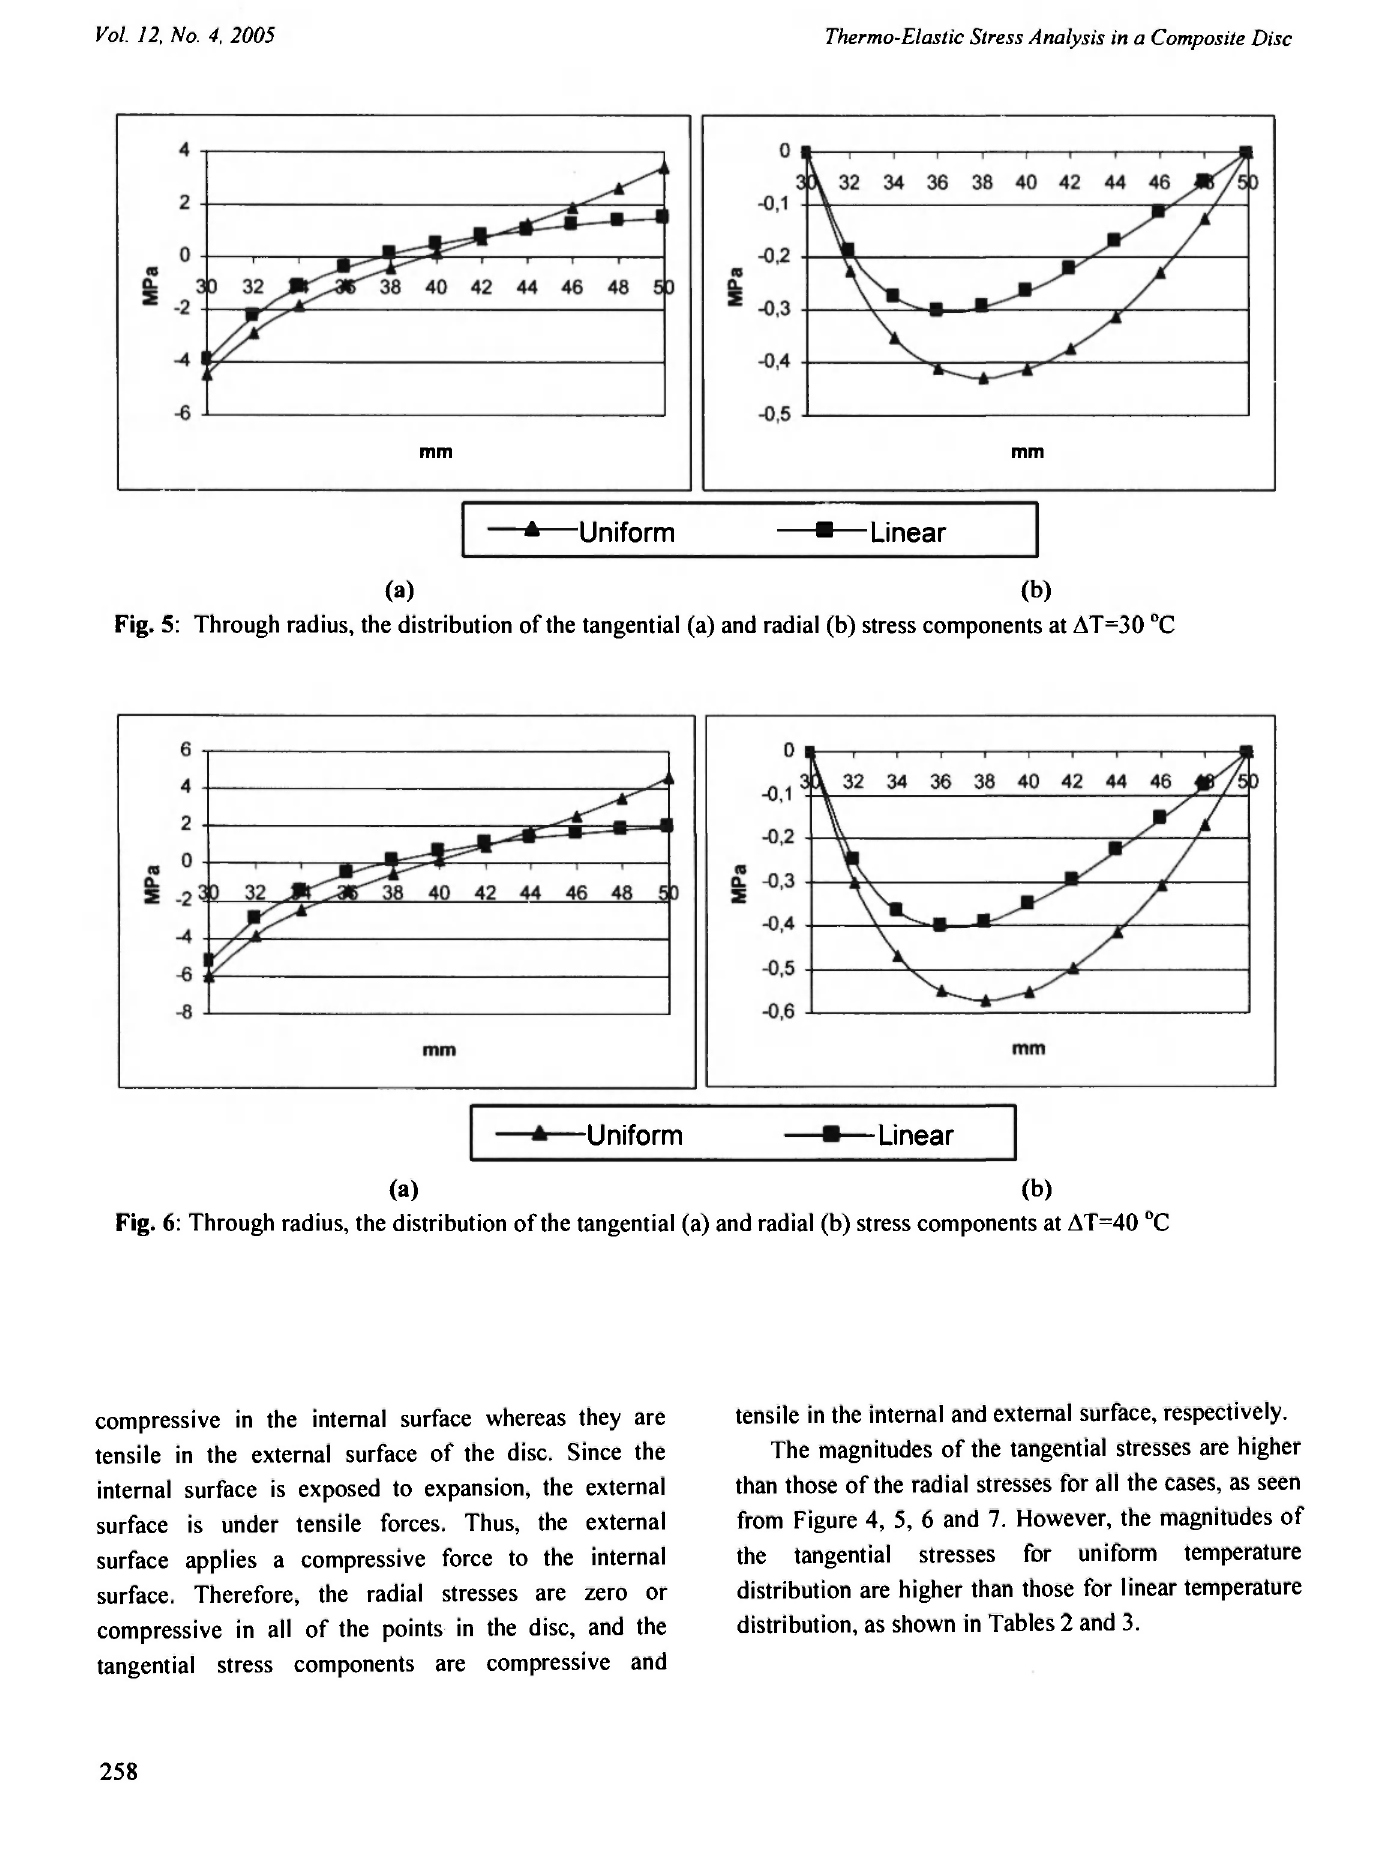
tensile in the internal and external surface, respectively. The magnitudes of the tangential stresses are higher than those of the radial stresses for all the cases, as seen from Figure 4, 5, 6 and 7. However, the magnitudes of the tangential stresses for uniform temperature distribution are higher than those for linear temperature distribution, as shown in Tables 2 and